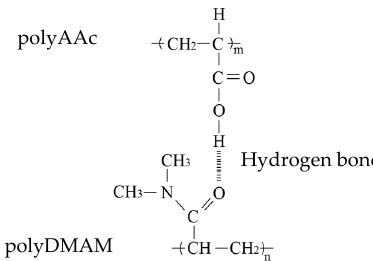
Figure 4. The polymer complexation of poly(acrylic acid) (polyAAc) with poly( N , N -dimethylacrylamide) (polyDMAM) by hydrogen bonding. When poly(VDP- co -DMAM) was mixed with polyAAc or polyMAAc, the fluorescent λ max